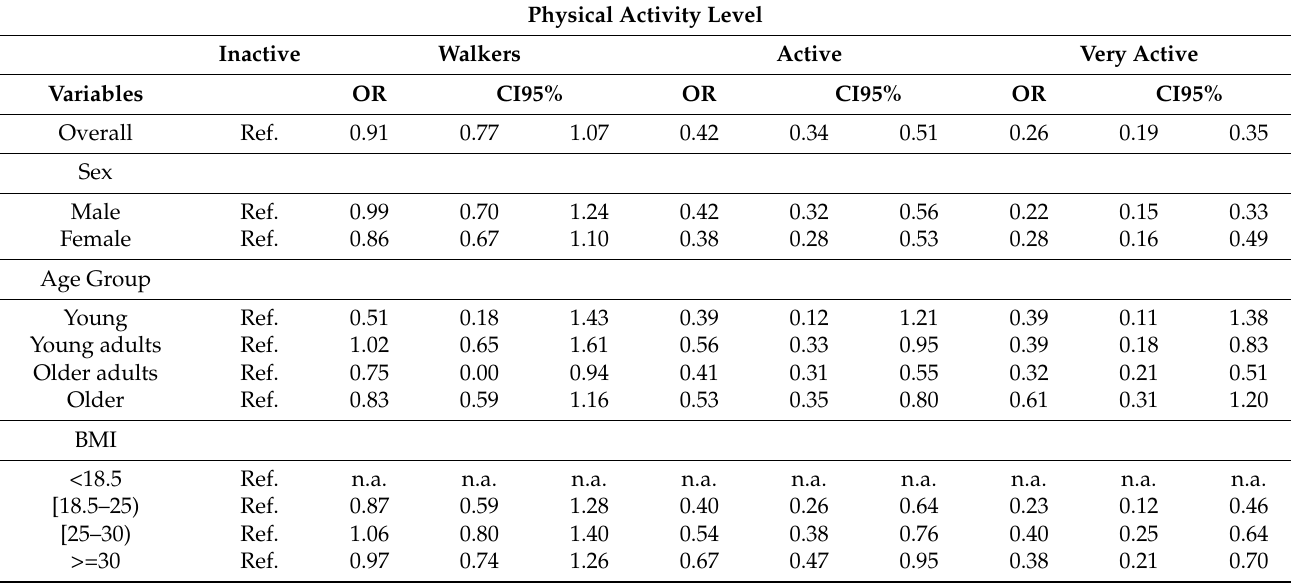
(Nagelkerke R 2 ) in the Diabetes status and Diabetes medication use, respectively (Table Table 6. Diabetes Medication Use Risk according to the Physical Activity Level.